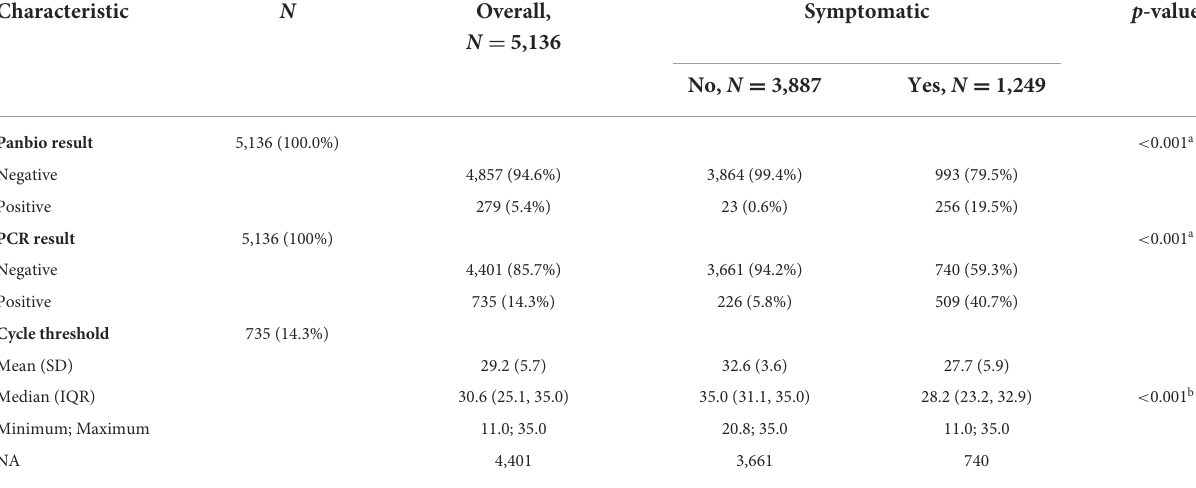
TABLE 2 Presence of symptoms.